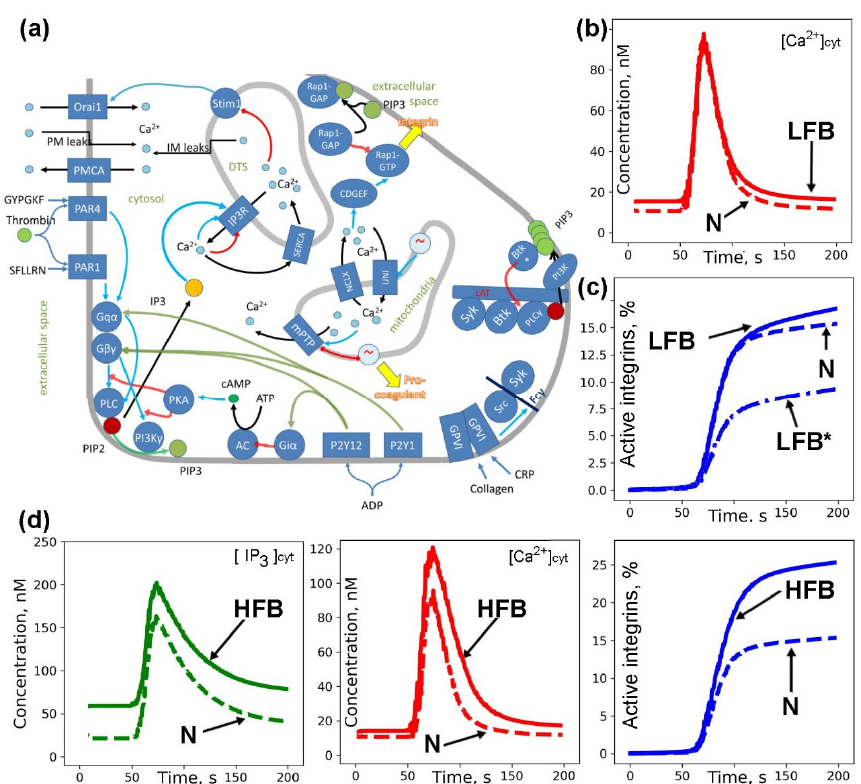
Figure 3. Increased cytosolic calcium as a result of platelet pre-activation or as a result of increased membrane calcium conductivity: computational models. ( a ) Scheme of signaling events. Platelet activation starts with a soluble ligand (thrombin, ADP or CRP) binding to a receptor on the platelet plasma membrane (blue rectangles). The activated G-protein coupled receptor induces heterotrimeric G-protein dissociation into α and βγ subunits. G α q and G βγ lead to phospholipase C (PLC) activation, while G βγ also leads to phosphoinositol-3-kinase (PI3K) activation. G α i leads to adenylate cyclase (AC) and protein kinase A (PKA) inhibition. CRP binds to GPVI receptor and induces its receptor clustering and their phosphorylation by half-active tyrosine kinases (Src), leading to binding and full activation of Syk and Src. Active kinases lead to PI3K and PLC γ activation. PLC activation leads to an increase in cytosolic free Ca 2 + concentration. Both Ca 2 + and PI3K lead to integrin activation through induction of small GTPase Rap1 association with GTP. Abbreviations. PAR—protease-activated receptor, P2Y—purinergic receptor, SERCA—sarcoplasmic / endoplasmic reticulum calcium ATPase, PMCA—plasma membrane calcium ATPase, CDGEF CalDAGGEFI, DTS—dense tubular system, Mit a mitochondrion, IP3R—receptor for inositol-1,4,5-trisphosphate (IP3), PIP2—phosphoinositol-4,5-bisphosphate, PIP3—phosphoinositol-3,4,5-trisphosphate, UNI—mitochondrial uniporter, NCLX—mitochondrial sodium / calcium exchanger, mPTP—mitochondrial permeability transition pore. ( b , c ) A computational model for platelet with increased membrane conductivity for calcium (LFB). Initial IP3 concentration (not shown) was assumed to be the same as in the initial model, while higher basal calcium concentration (( b ), solid red) was sustained by increased calcium influx through the membrane without significant integrin activation (( c ), solid blue). Stimulation with ADP (2 µ M at 50 s) lead to the same maximal calcium concentration and integrin activation as in the initial model (N, dashed curves). In the case when one of the signaling protein is damaged, the integrin activation becomes lower (LFB* model, dash-dot curve) ( d ) Computational model for pre-activated platelet (HFB). Initial IP3 concentration (solid green) was assumed to be higher due to pre-activation, which lead to higher basal calcium concentration (solid red) without significant integrin activation (solid blue). Stimulation with ADP (2 µ M at 50 s) lead to higher maximal calcium concentration and integrin activation compared to the initial model (N, dashed